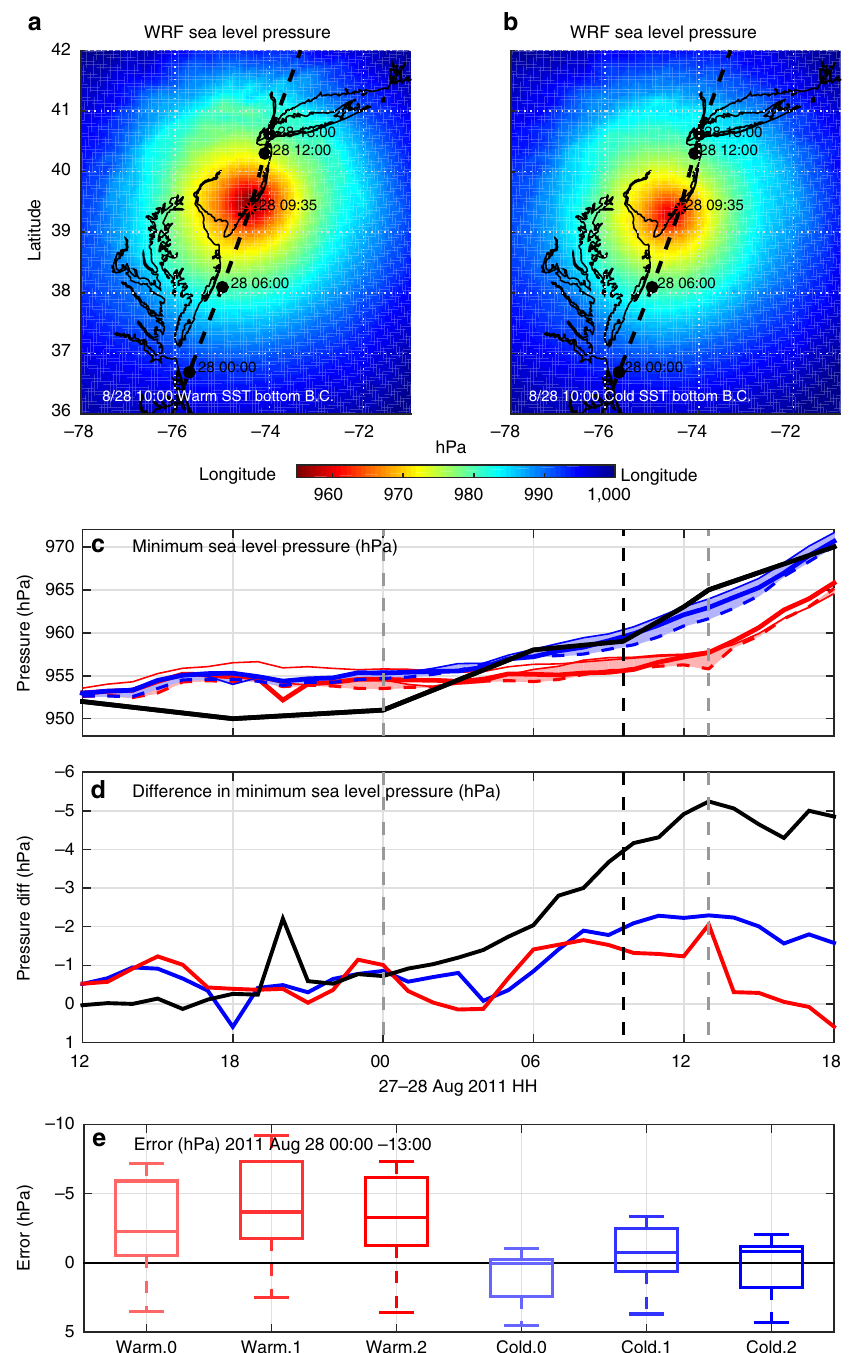
Figure 4 | WRF atmospheric model simulation results. ( a ) WRF model SLP (with surface flux option 2) at landfall (red star) for the warm SST boundary condition with NHC best track drawn as in Fig. 1a. ( b ) Same as a but for the cold SST. ( c ) Minimum SLP for NHC best track (black), and WRF’s three air–sea flux parameterization options isftcflx ¼ 0 (thin line); 1 (dotted line); and 2 (thick line) for the warm (red) and cold (blue) SST. Vertical grey and black dashed lines indicate eye enters MAB, makes landfall and leaves MAB. ( d ) Model SLP sensitivity to SST (black, warm minus cold SST for isftcflx ¼ 2), and to flux parameterizations (isftcflx ¼ 1 minus isftcflx ¼ 0) for warm (red) and cold (blue) SST. ( e ) Box and whisker plots of SLP deviations from NHC best track when eye is over MAB for warm (red) and cold (blue)